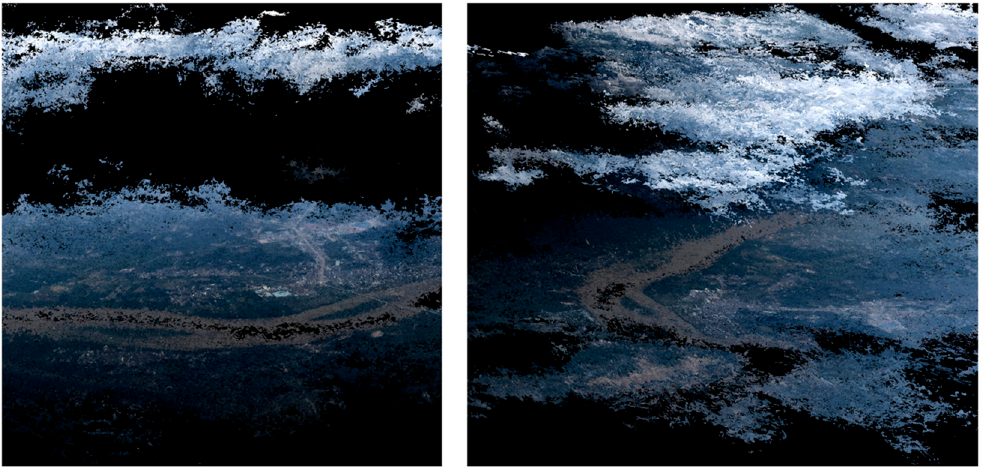
Figure 4. The derived point cloud shows that the clouds above the ground are clearly